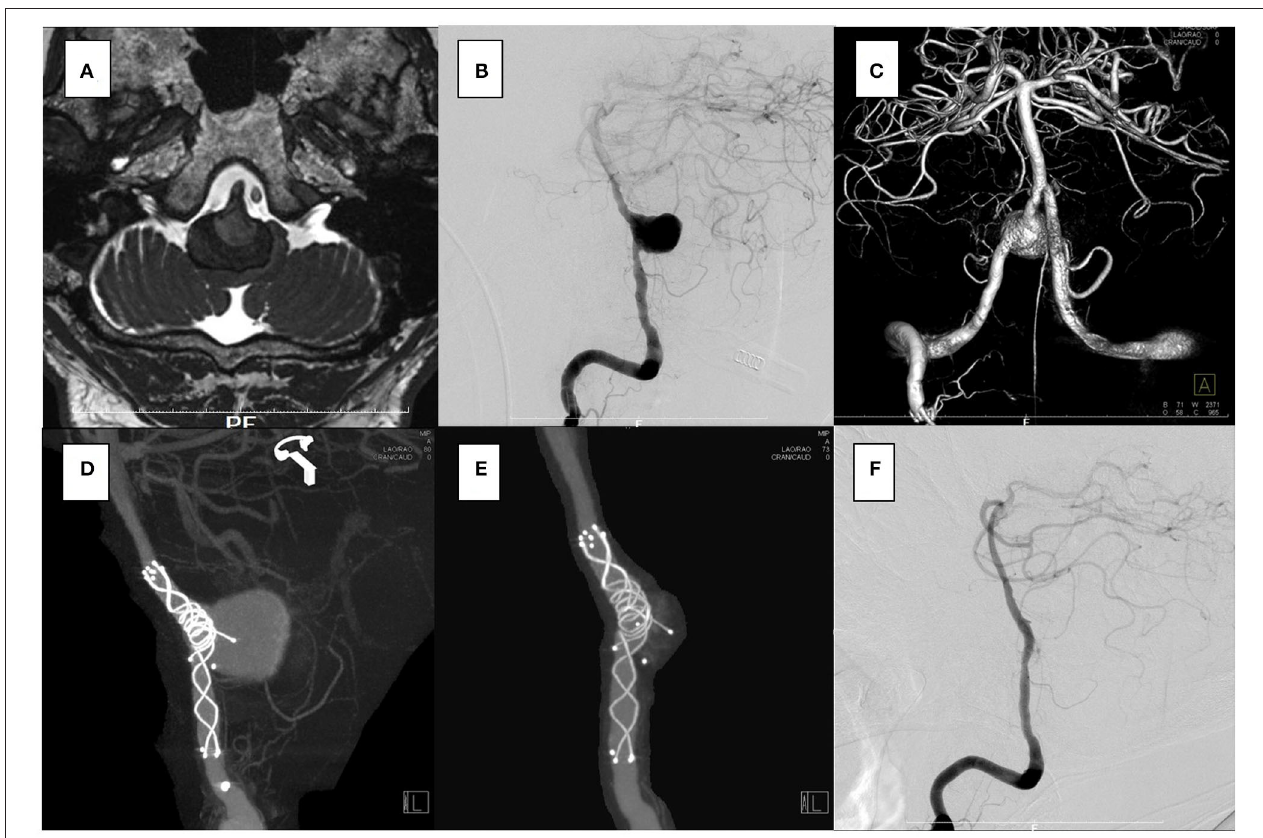
FIGURE 3 | In the case 2, the patient presented with left hemiparesis and dysphasia. His brain stem was compressed by a large partially thrombosed vertebral artery aneurysm. (A–C) Overlapping stents with double low-profile visualized intraluminal support (LVIS) were placed (3.5 × 22mm, 4.5 × 32mm). The first stent was shortened when a micro catheter was advanced to the distal end of the vertebral artery, but it covered the aneurysm orifice. (D) After 2 weeks, the follow-up angiography showed that the aneurysm was closed off. (E,F) No recanalization has been seen for 2